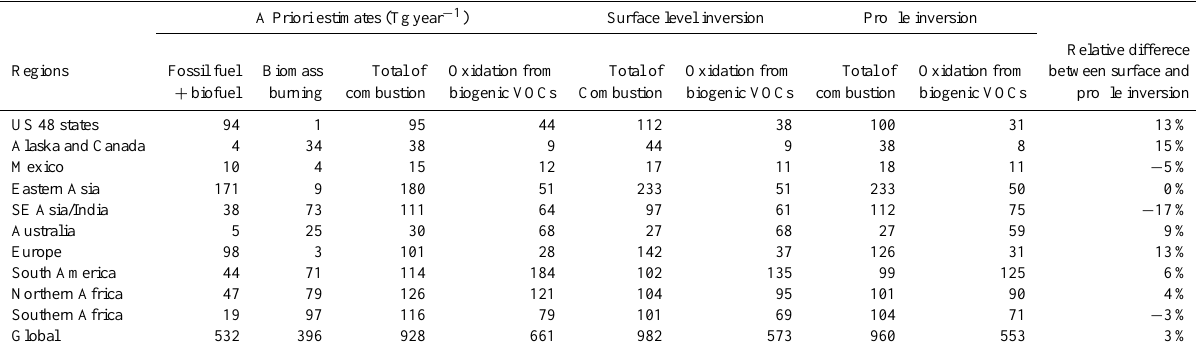
Table 1. Annual total CO emission in different regions, from June 2004 to May 2005, constrained by MOPITT surface level and tropospheric profile retrievals. The relative difference on total (combustion + oxidation from biogenic VOCs) CO emission estimates is calculated by 2 · (CO_surface–CO_profile) / (CO_surface + CO_profile). The region definition is shown in Fig. 1.